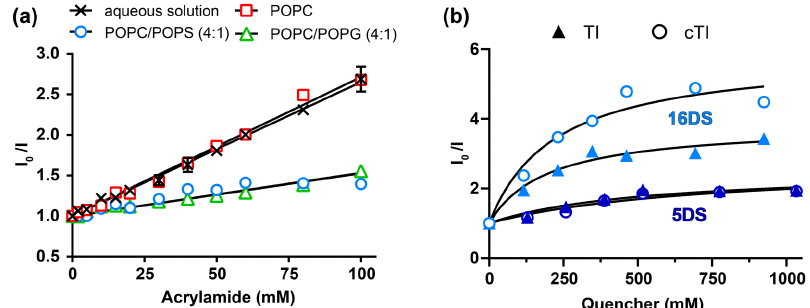
Figure 6. The effect of aqueous (acrylamide) and lipidic (5DS and 16DS) quenching on the tryptophan fluorescence intensity to investigate peptide in-depth location within model membranes. ( a ) The Trp fluorescence emission of 12.5 µ M cTI in aqueous solution or in the presence of LUVs (1 mM POPC (1-palmitoyl-2-oleoyl-sn-glycero-3-phosphocholine), 1 mM POPC/POPS (1-palmitoyl-2-oleoyl-sn-glycero-3-phosphoserine; 4:1), 0.1 mM POPC/POPS (4:1) or 0.1 mM POPC/POPG (1-palmitoyl-2- oleoyl-sn-glycero-3-phosphoglycerol; 4:1)) in the absence (I 0 ) and upon titration with increasing concentrations of acrylamide (I). Data are shown as Stern-Volmer plots (i.e., I 0 / I versus concentration